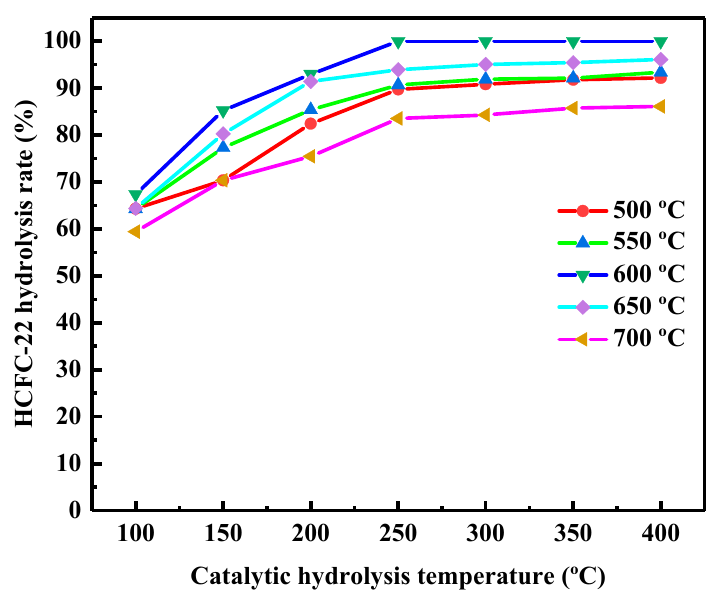
Figure 4. Effects of the catalyst calcination temperatures and catalytic hydrolysis temperatures on the hydrolysis rate of HCFC-22 (feed gas composition (mol %): 4.0 HCFC-22, 25.0 H 2 O(g), 10 O 2 , and N 2 ; the total flow rate was 15 cm 3 /min and catalyst was 1.0 g).